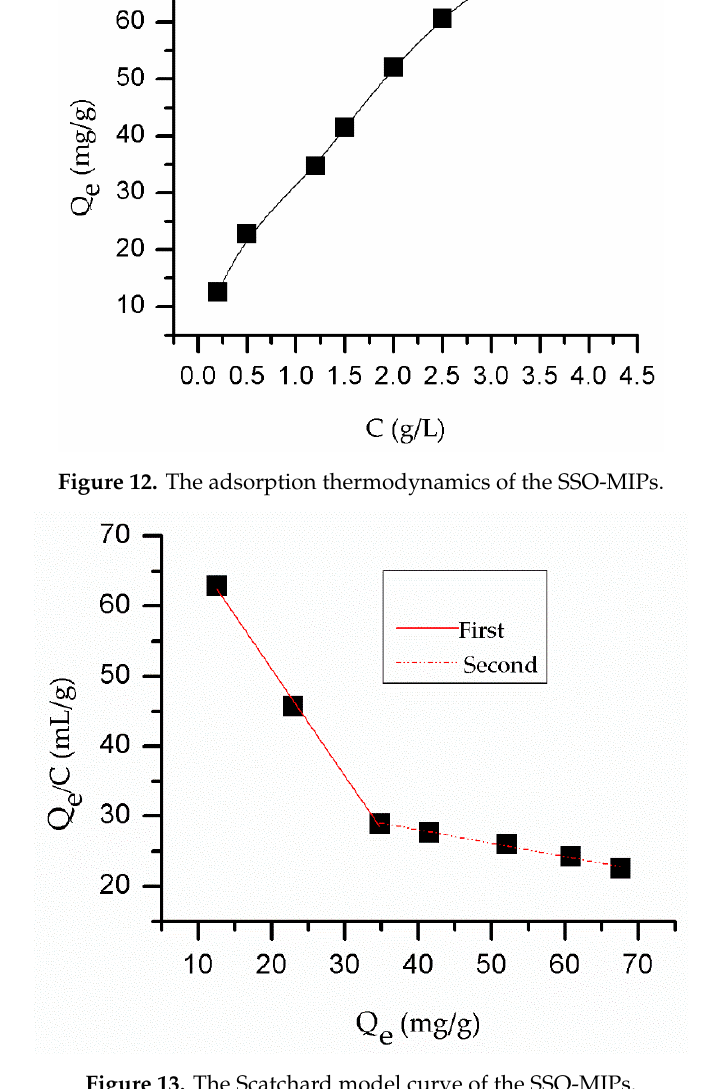
Figure 13. The Scatchard model curve of the SSO-MIPs.